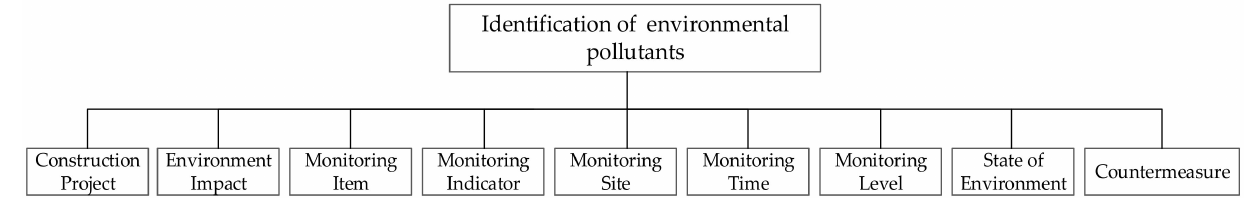
Figure 2. Basic classes of the ontology model for identifying environmental pollutants. (4)